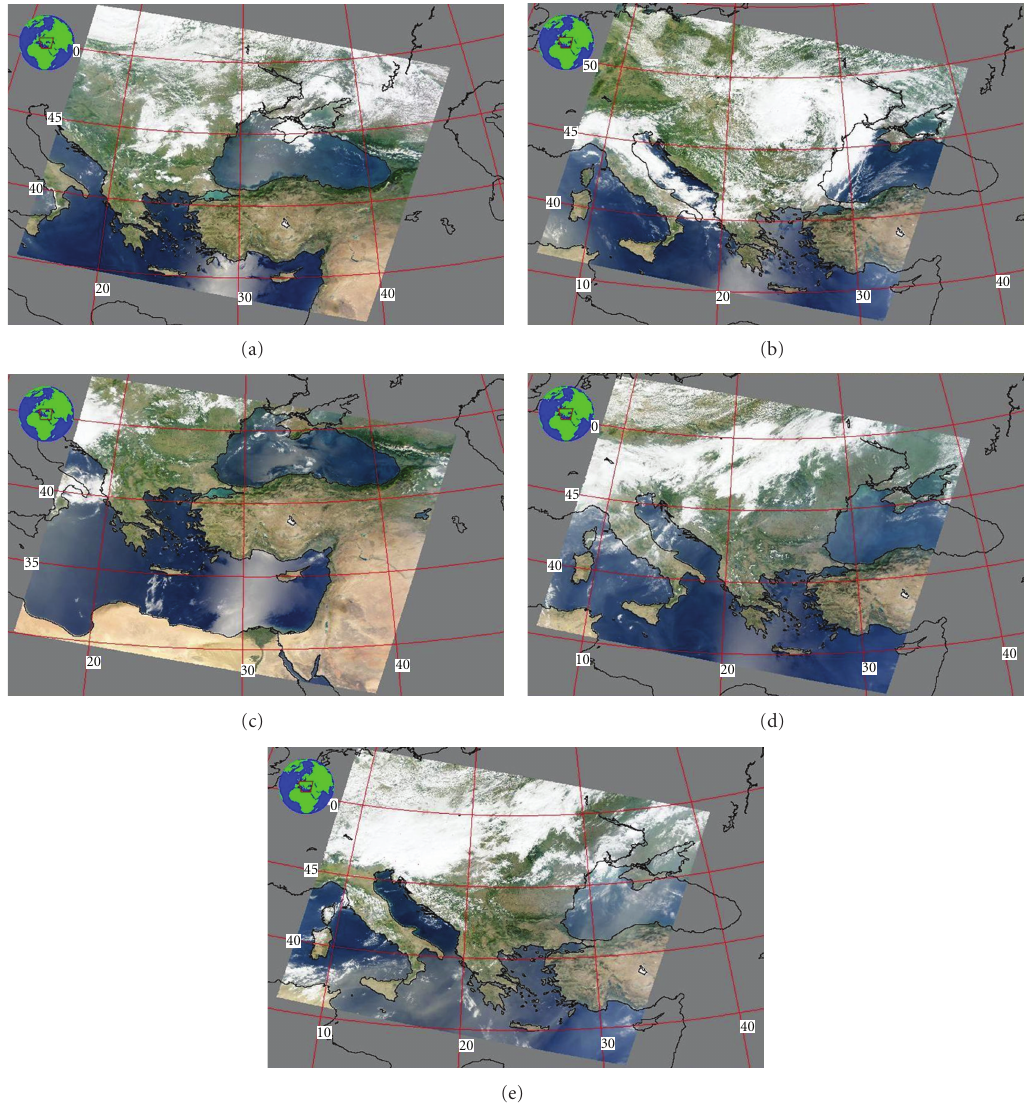
Figure 1: True color images from Terra-MODIS sensor on five days in summer 2003, (a) on 22/6/03, (b) on 4/7/03, (c) on 14/7/03, (d) on 15/8/03, and (e) on